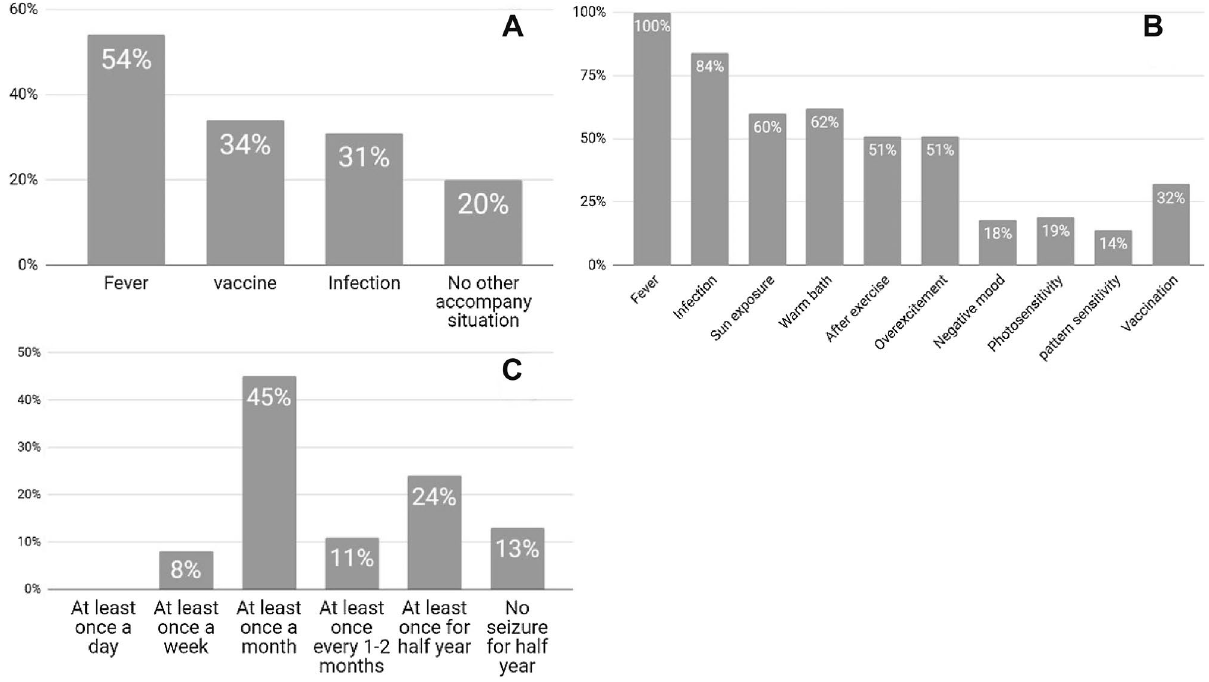
Figure 2. Questionnaire findings regarding seizure evaluation. ( A ) Situations accompanying the first seizure occurrence. ( B ) Situations accompanying the subsequent seizures. ( C ) Seizure